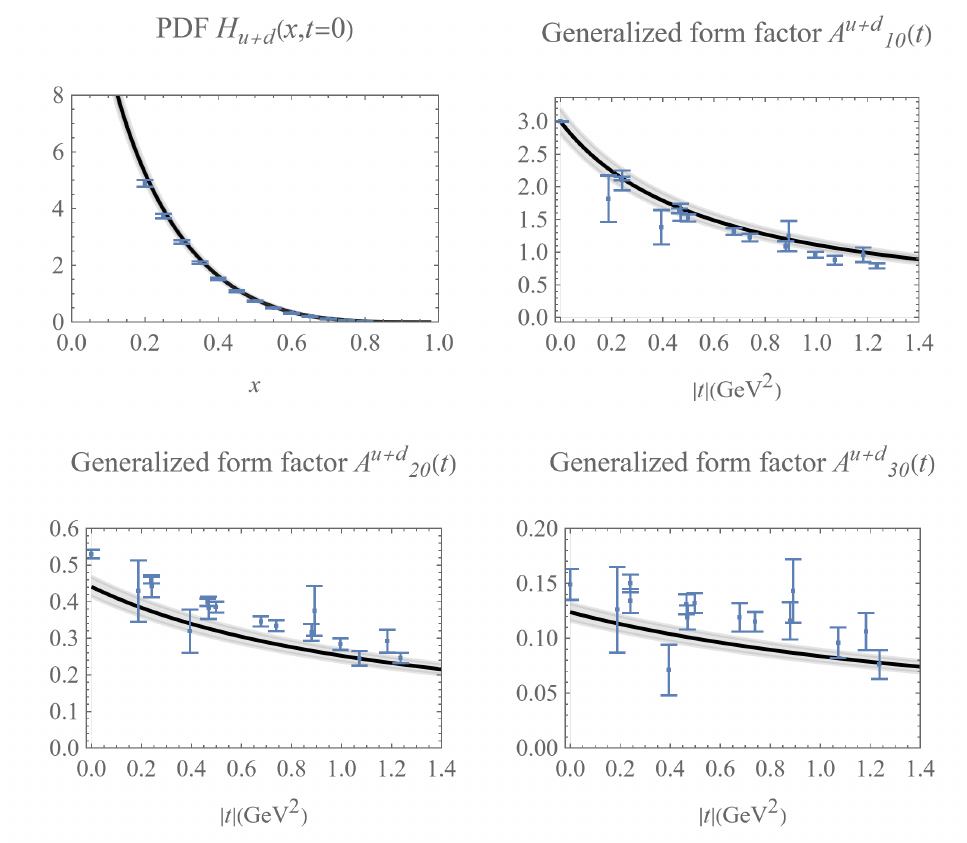
Figure 7 . A simultaneous fit to the forward PDF H u + d ( x ) (corresponding to the PDF q u + d ( x ) ) [43, 44] and generalized form factors A u + d are the central value of H u + d ( x, t ) , the gray bands are the regions within 1 σ uncertainty and the dots are measurements that are fitted to. The χ 2 per d.o.f. is 8.47 for our 4 parameters fitting. The parameters from the fitting read N H scal = 8 . 340 (263) , α H scal = 0 . 210 (10) , β H scal = 3 . 584 (43) and α 0 = 1 . 338 (27) H scal